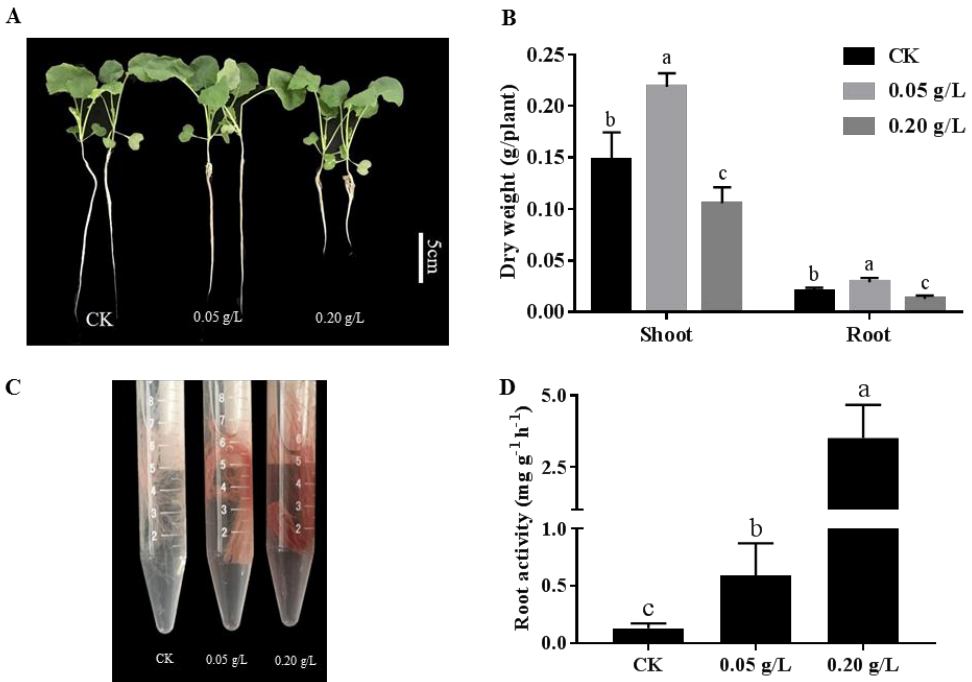
Figure 2. Effects of different concentrations of CMS on rapeseed seedling growth ( A ), biomass ( B ) and root vitality ( C and D ). Control (CK) is a full-strength Hoagland’s solution. Two concentrations (0.05 and 0.2 g L −1 ) of CMS were added to the Hoagland’s solution. Different letters indicate the significant